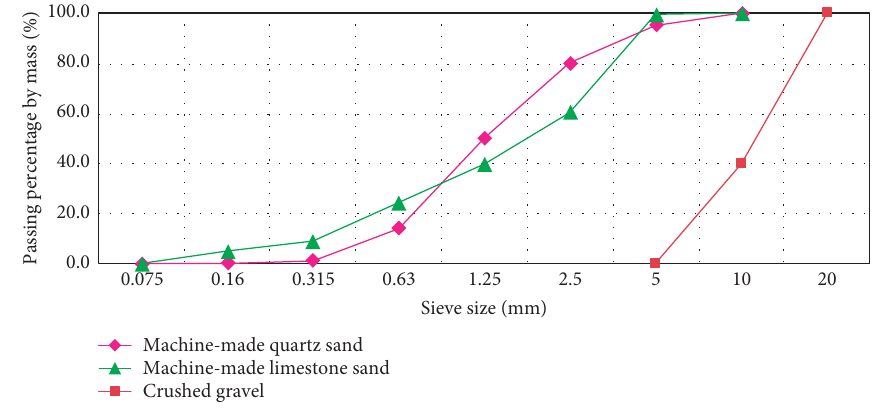
Figure 3: Particle size distribution curves of sand and crushed